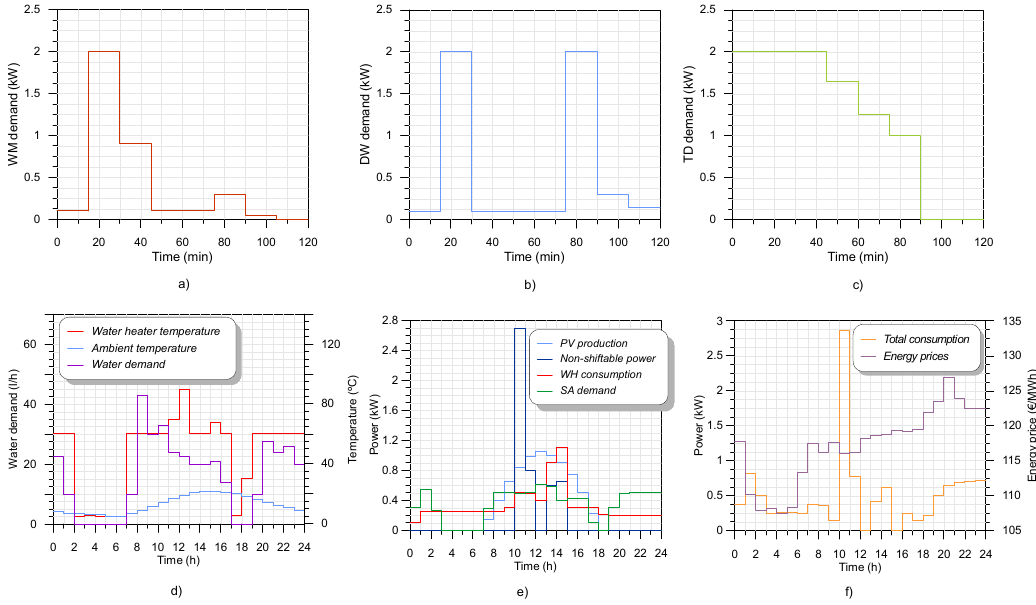
Figure 4. ( a – c ) Smart appliances power demands; ( d ) hot water demand, ambient temperature, and water heater (WH) temperature once the model is solved; ( e ) photovoltaic (PV) production, non-shiftable power, WH demand, and decoupled demand of the SA; and ( f ) total demand consumption and real time prices.